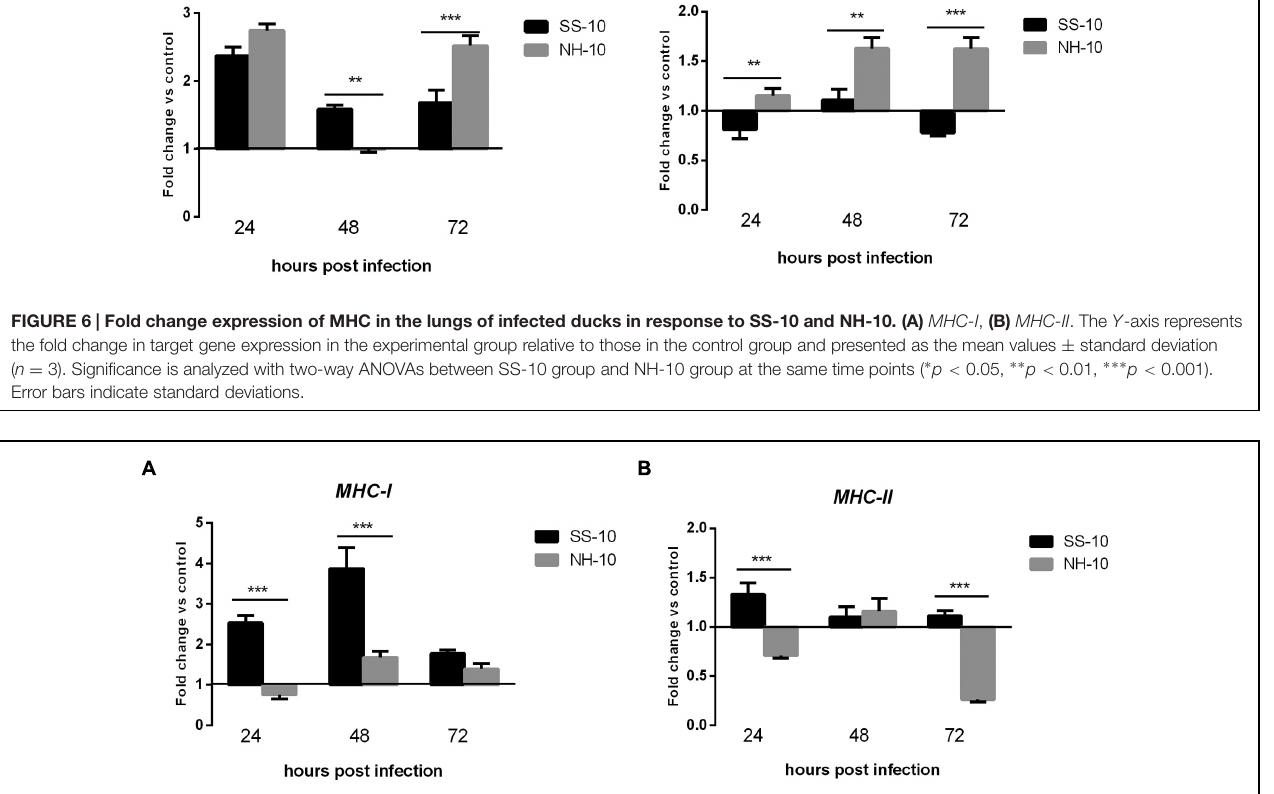
FIGURE 7 | Fold change expression of MHC in the thymuses of infected ducks in response to SS-10 and NH-10. (A) MHC-I , (B) MHC-II . The Y -axis represents the fold change in target gene expression in the experimental group relative to those in the control group and presented as the mean values ± standard deviation ( n = 3). Significance is analyzed with two-way ANOVAs between SS-10 group and NH-10 group at the same time points ( ∗ p < 0.05, ∗∗ p < 0.01, ∗∗∗ p < 0.001). Error bars indicate standard